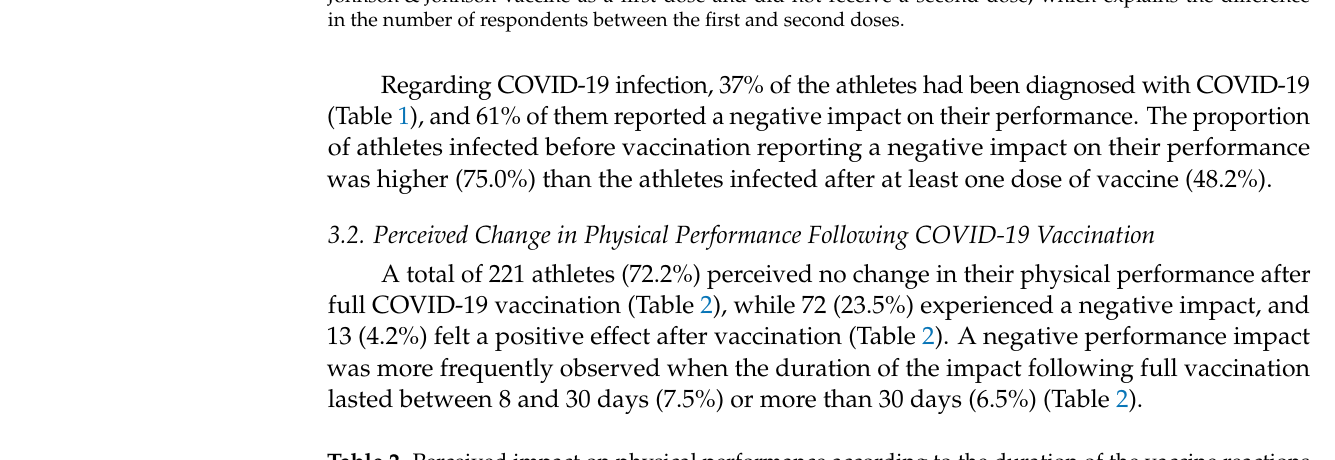
Table 2. Perceived impact on physical performance according to the duration of the vaccine reactions ( n =